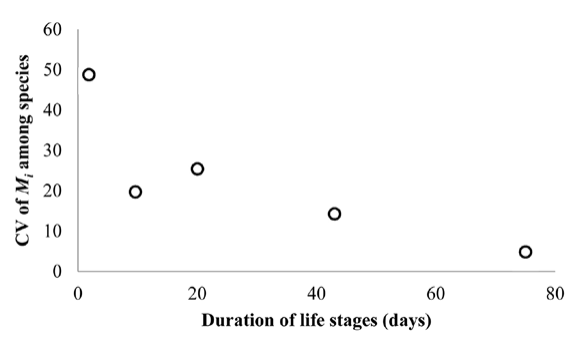
Fig. 2. – Decrement in the coefficient variation (CV) of the natural mortality at age ( M ) among the brown ( F. californiensis ), blue ( L. i stylirostris ) and white ( L. vannamei ) shrimps in relation to the dura- tion of their life stages (not including egg and pre-adult